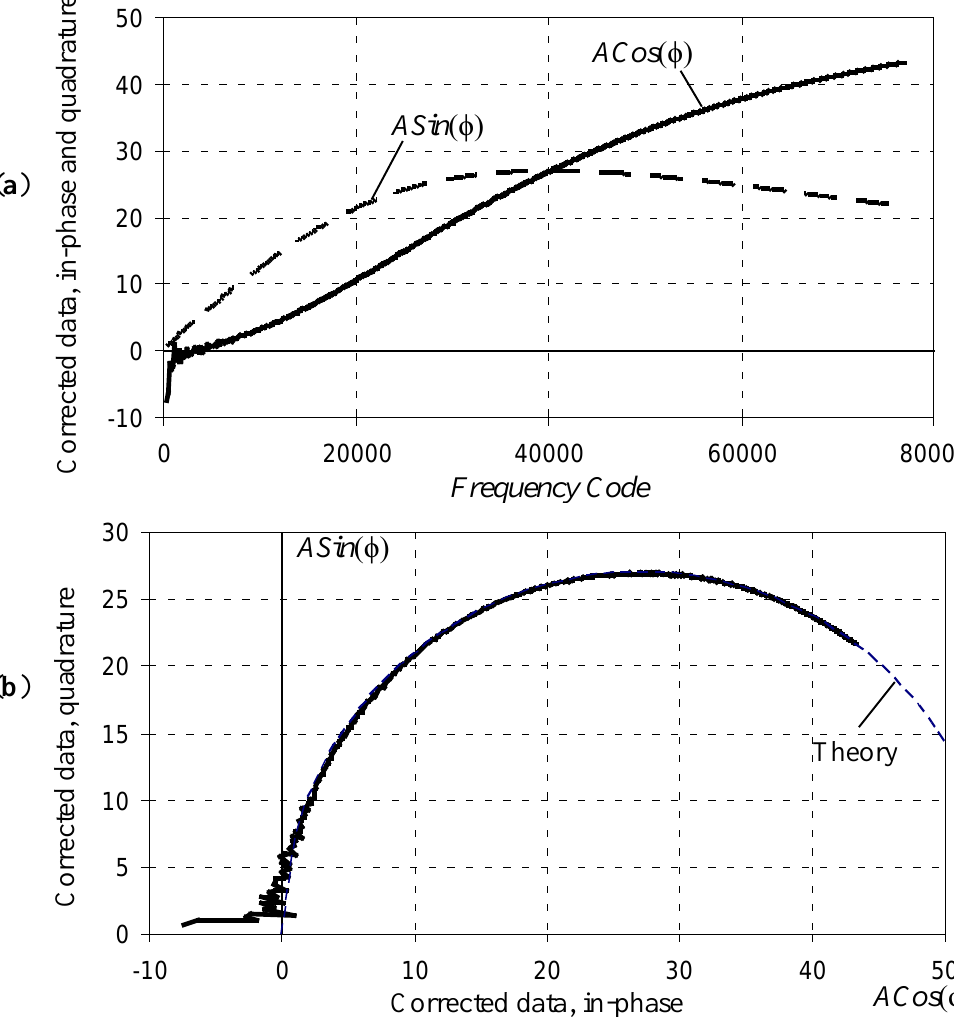
Figure 11. “Real” and “Imaginary” data for 140 kΩ resistor and 1nF capacitor sequential RC network collected by AD5933, processed according to Equations (3) and plotted: ( a ) as functions of frequency, and ( b ) on a complex plane: quadrature response ASin (ϕ) as a function of in-phase response ACos